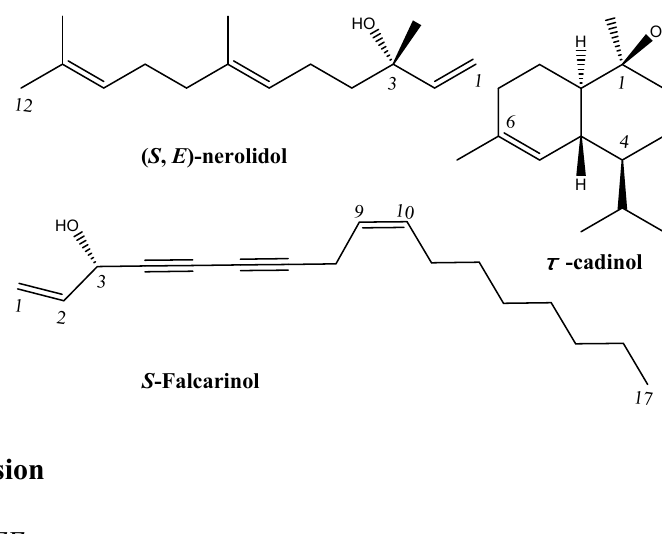
Figure 1. Chemical structures of the isolated volatile